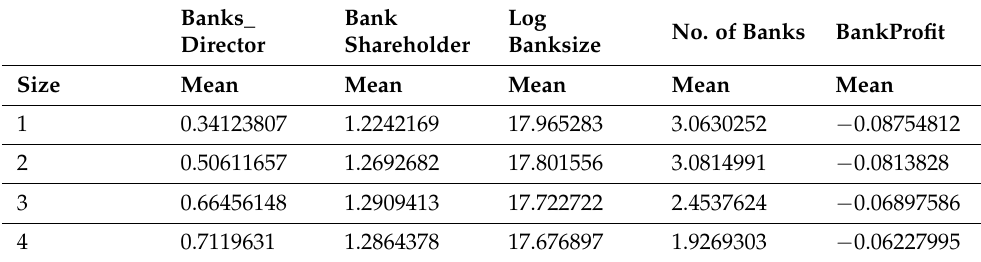
Table 8. Bank characteristics by company